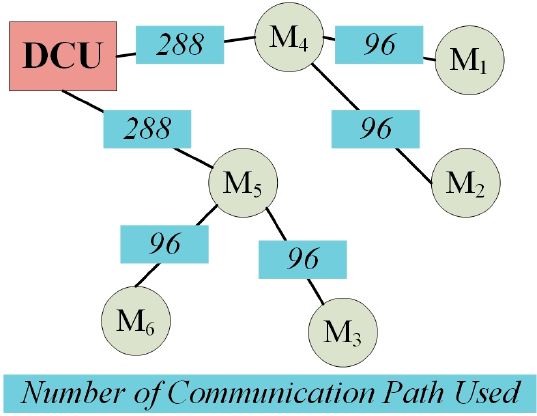
Figure 14. Number of Communication Paths Used for the Six-Meter Case after Communication Paths Changed.